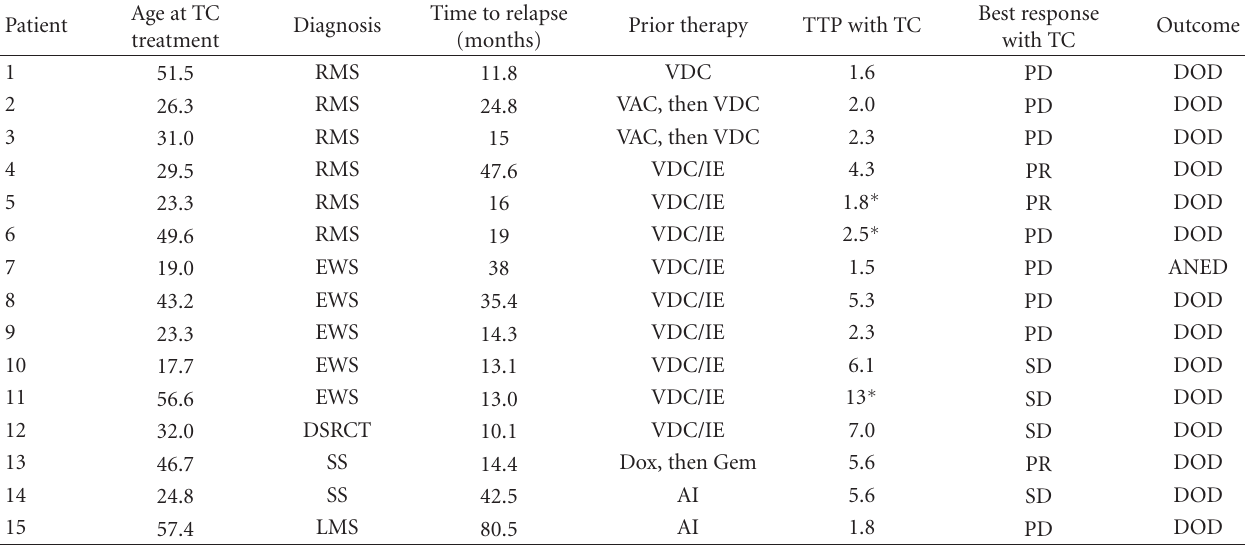
Table 2: Treatment and disease outcome in patients treated with topotecan/cyclophosphamide.